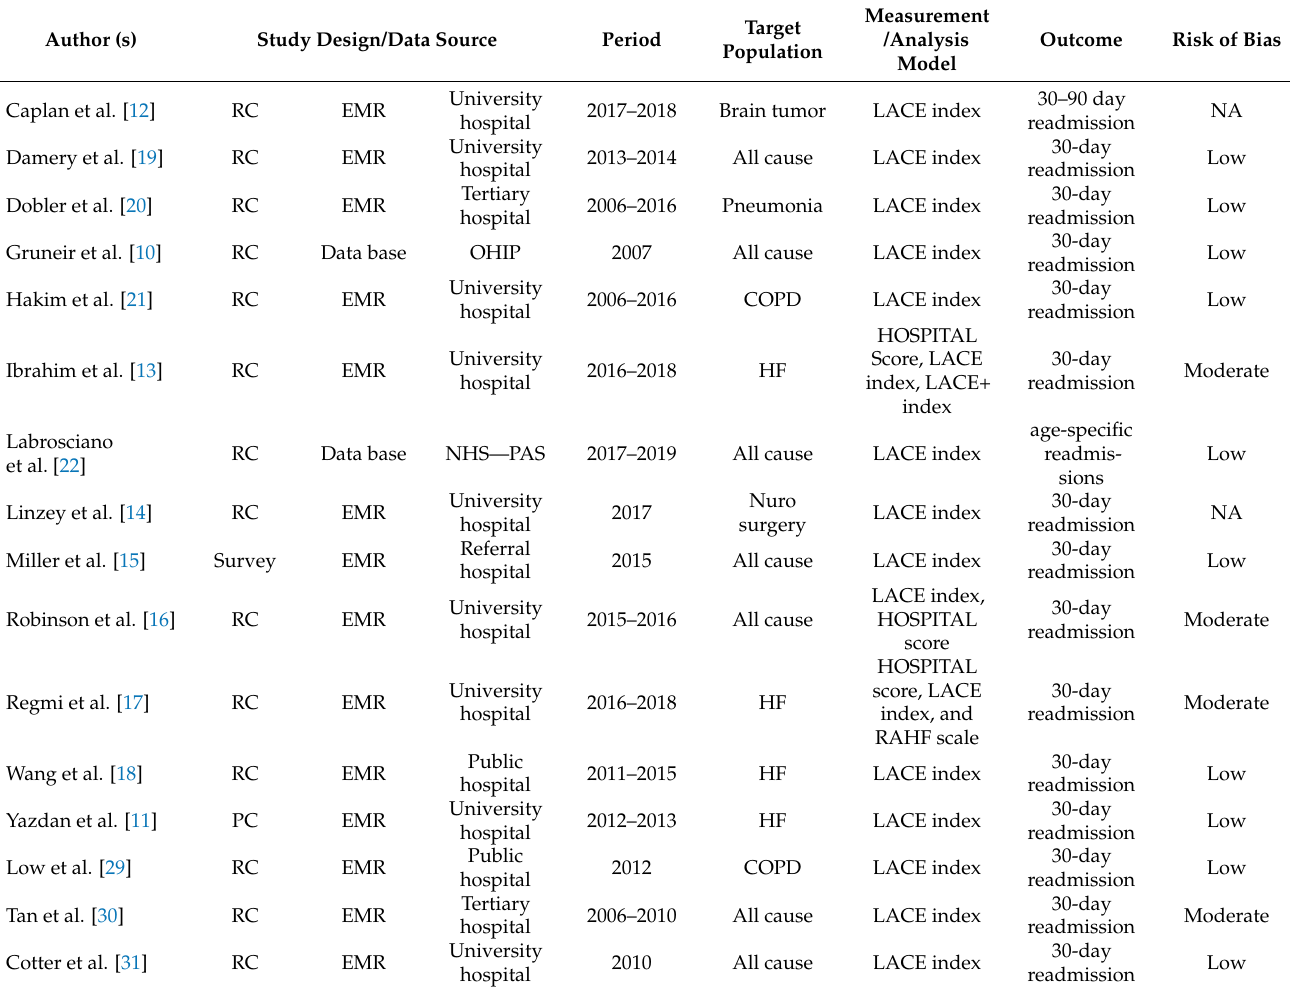
Table 1. Summary of the Included Studies Regarding Lace index to predict 30-day readmissions with Quality Assessed Using the Cochrane Risk of Bias